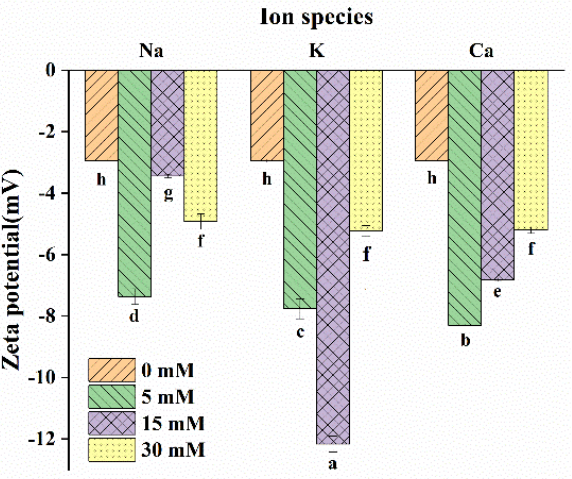
Figure 1. Effect of salt ion species and concentration on the potential of the low methoxyl pectin/sodium caseinate (LMP/CAS) complex. Different letters below the bars indicate a significant difference ( p < 0.05).